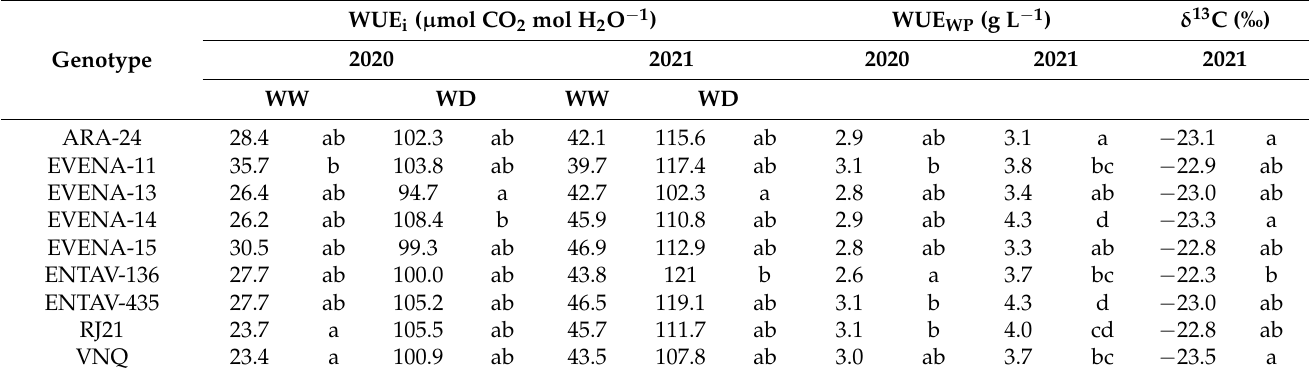
Table 5. Intrinsic water use efficiency (WUE i ), whole plant water use efficiency (WUE WP ), and carbon isotope ratio in grapes ( δ 13 C) for each of the 9 “Grenache” genotypes under well-watered (WW) and water deficit (WD) conditions during 2020 and 2021 seasons in Mallorca,